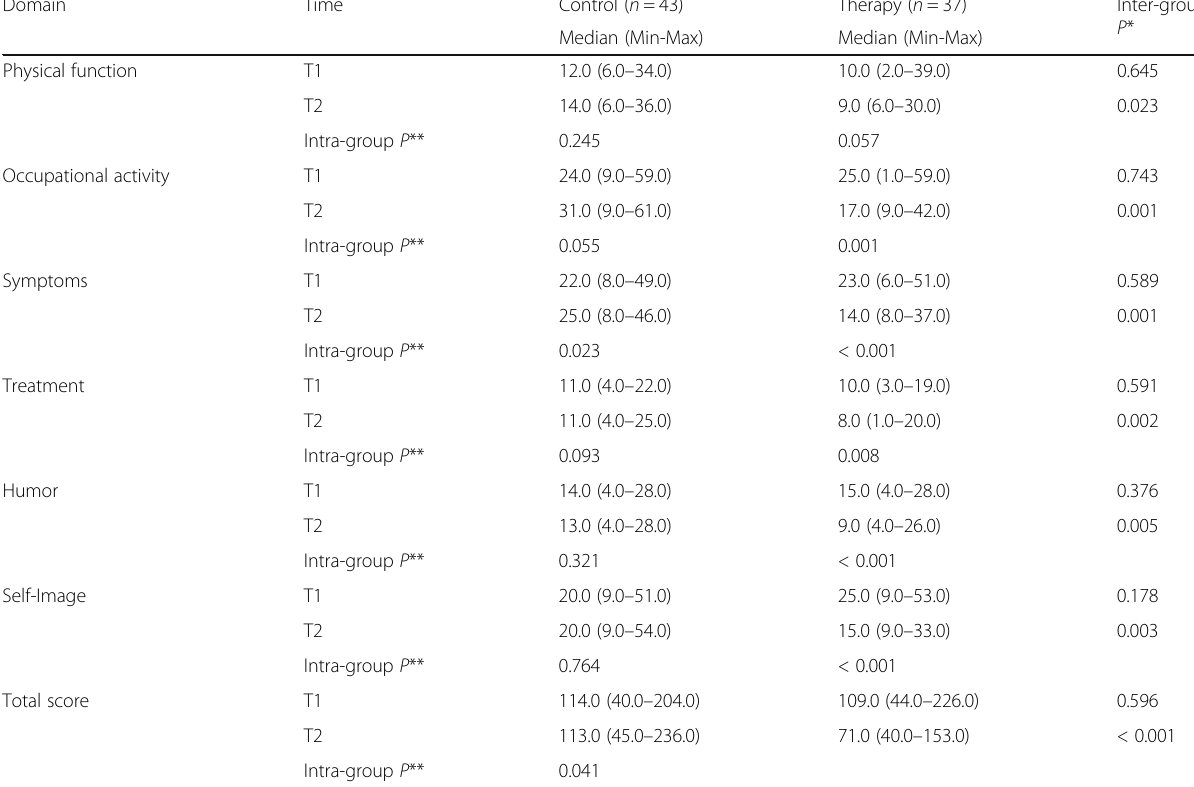
Table 4 Quality of life scores of SLE patients in control and therapy groups over time Domain